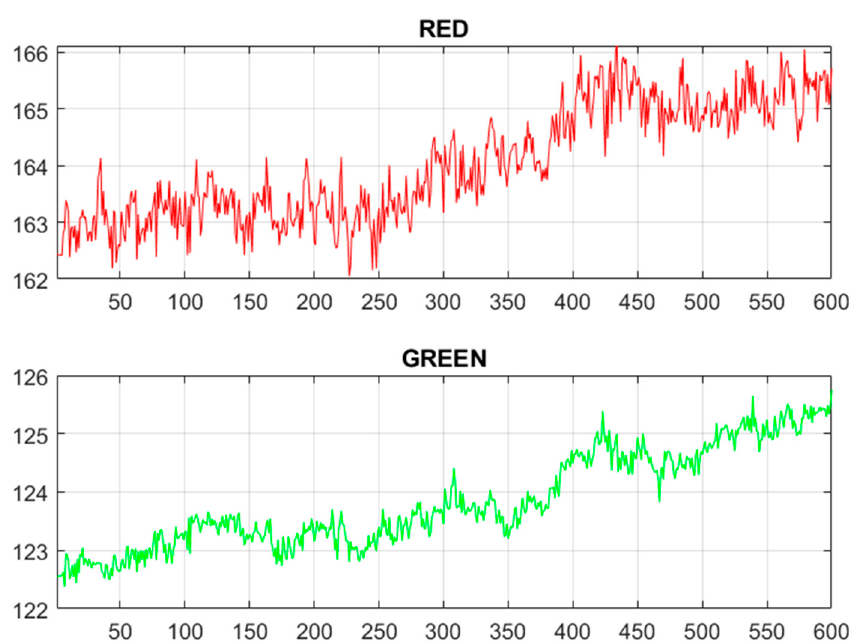
Figure 5. Average pixel signals for the red and green channels.